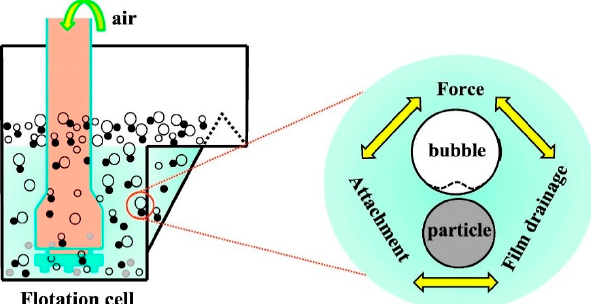
Figure 2. Concept of dissolved air flotation (DAF) system. Reprinted with permission from ref. [32]. Copyright 2017 Elsevier B.V.